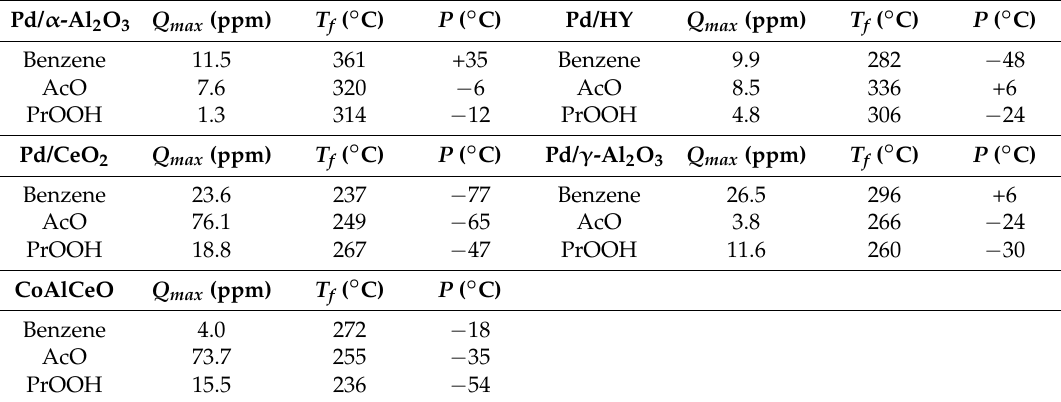
Table 8. Parameters characterizing the emission profiles of binary mixture